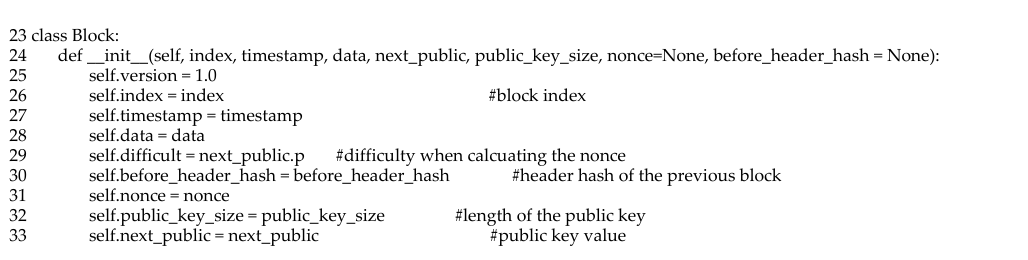
Figure 9. Class definition of the header of the block.